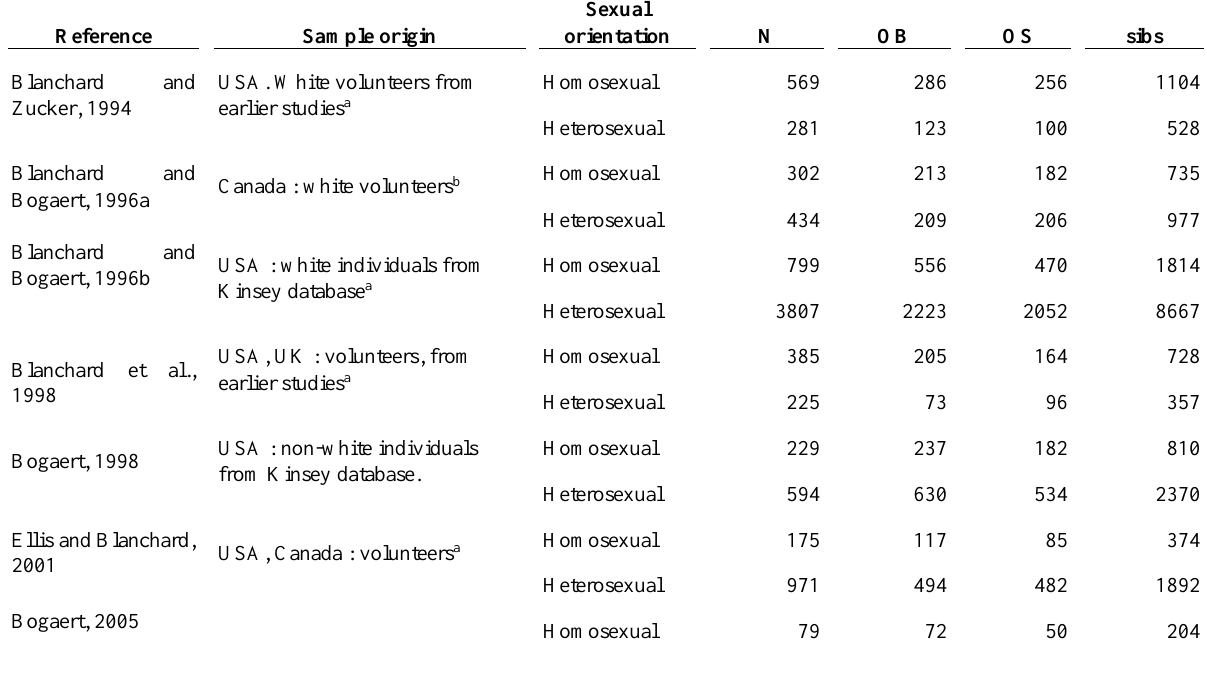
Table 1 . Aggregated data collected from published studies. For each pair of homosexual and heterosexual male (older and younger) are shown, as well as the origin of the sample and the